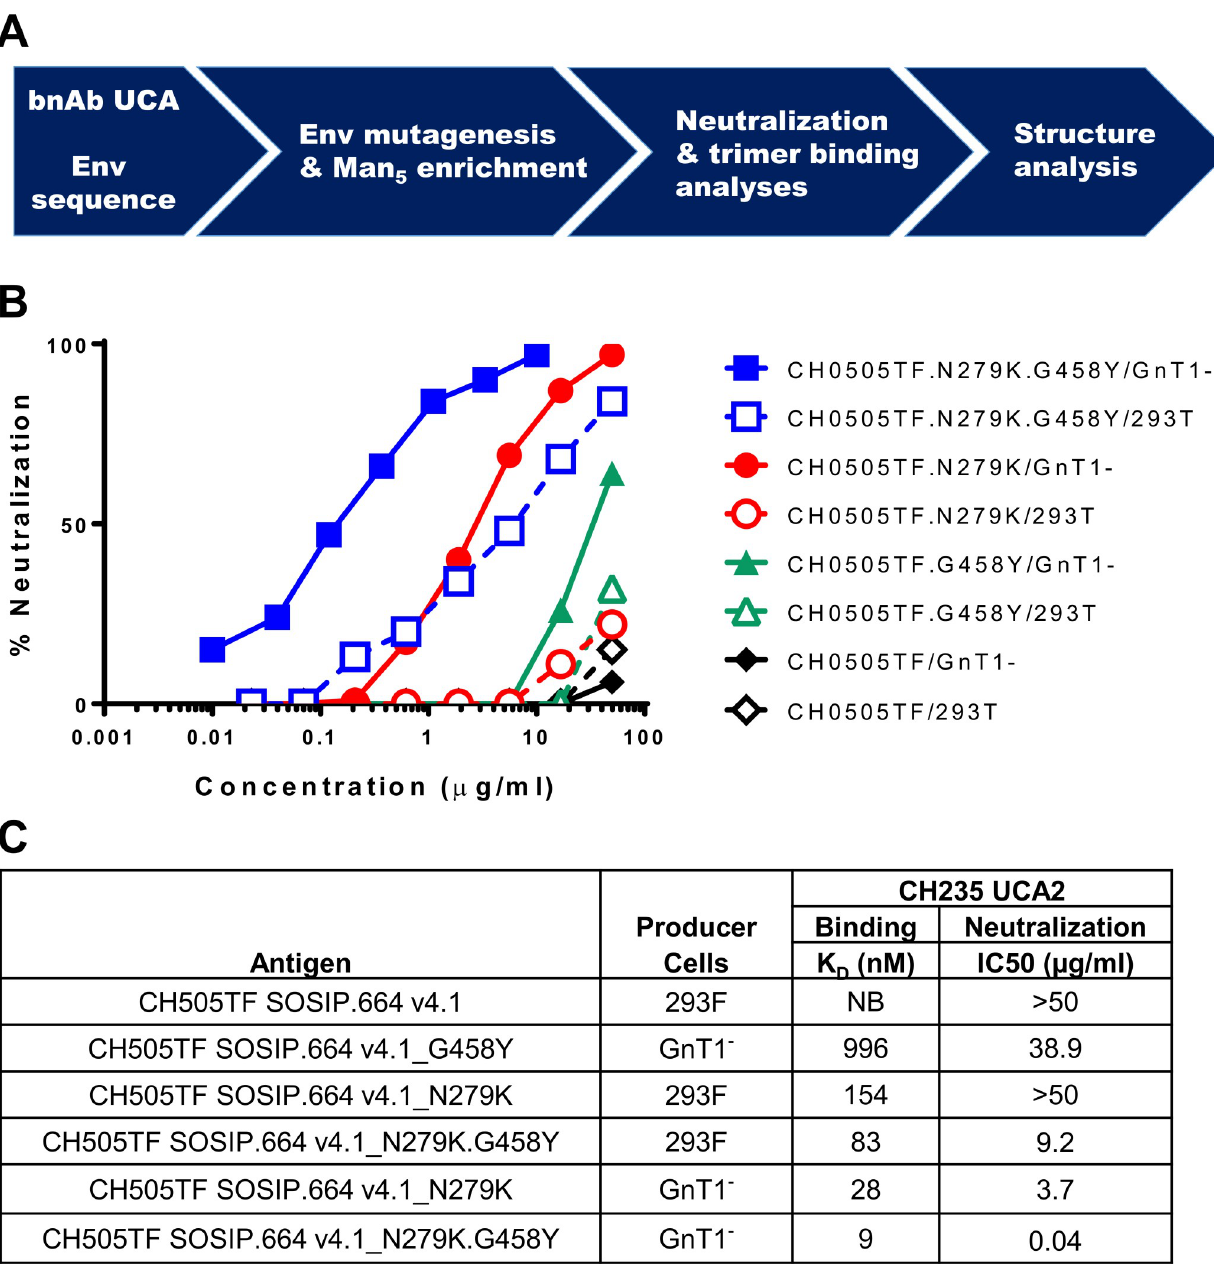
CH235 compared to Man -enriched CH505TF (Fig 1, S1I–S1K Fig). These mutations had little 5 or no impact on neutralization by VRC01gl, CH103 UCA and intermediates of CH103 com- pared to corresponding CH505TF produced in 293T and GnT1 - cells (Fig 1, S1A–S1G Fig).